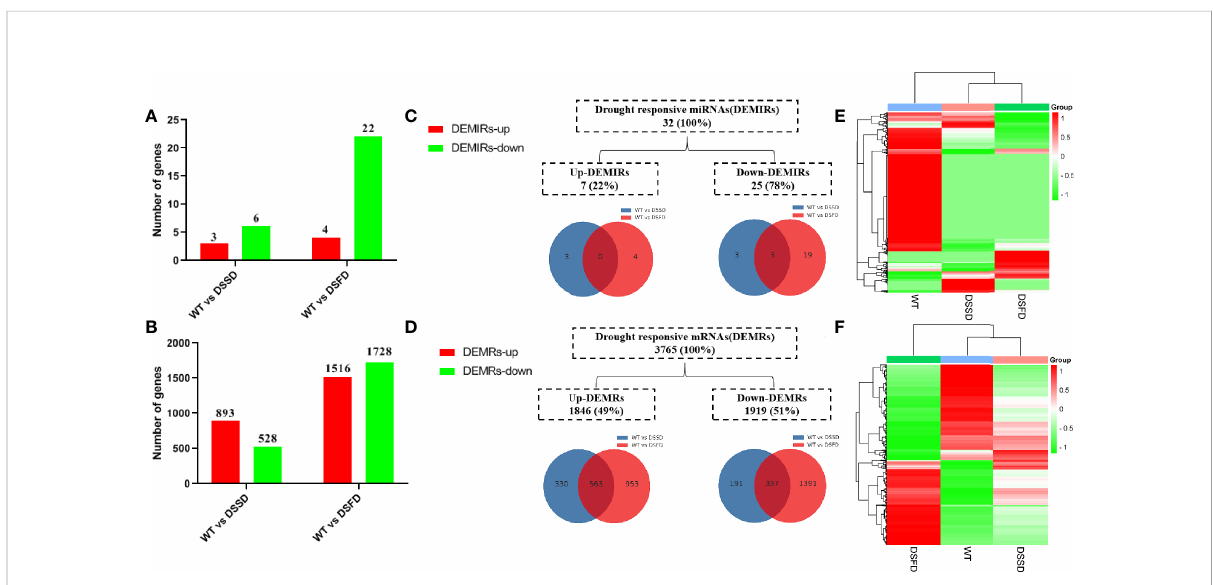
FIGURE 2 The expression pro fi le of drought stress-regulated DEMIRs and DEMRs in maize roots. (A, B) Column diagram representing the numbers of DEMIRs and DEMRs. (C, D) Venn diagrams representing the numbers of DEMIRs and DEMRs, and the overlaps of sets obtained across two comparisons. (E, F) Heat map of all miRNAs and all mRNAs expression pro fi les before and after drought stress.